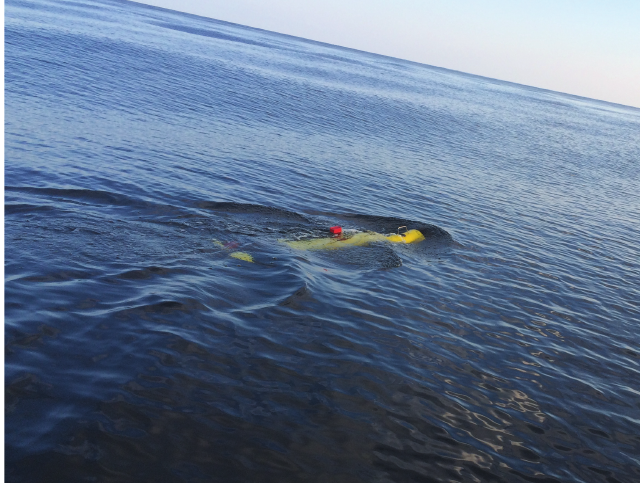
Figure 14. Sailfish AUV platform during the